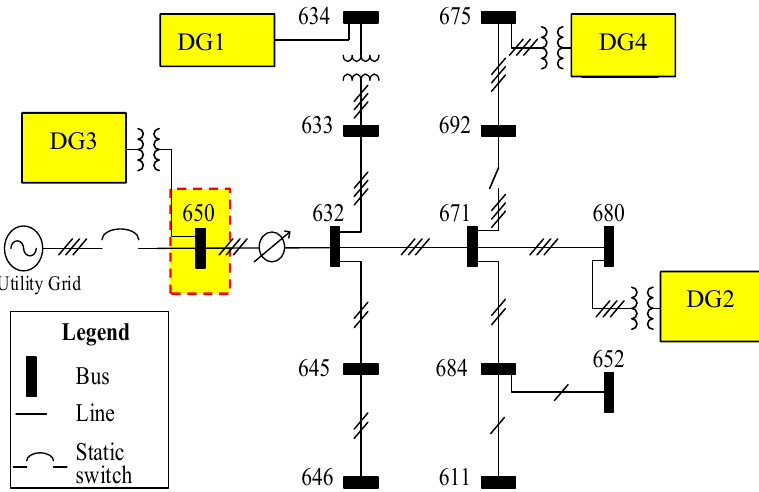
Figure 9. Microgrid test case based on IEEE 13-bus system.